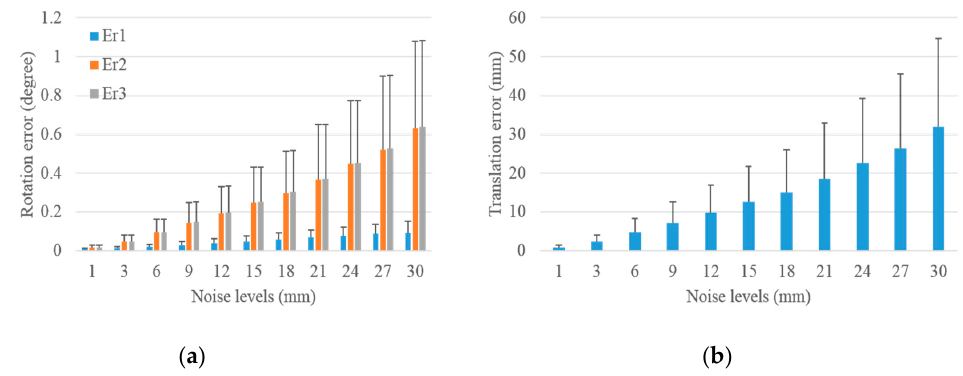
Figure 9. Rotation and translation errors for the extrinsic calibration of LRF with respect to the camera under increasing range noise levels. ( a ) Rotation error and ( b ) translation error.